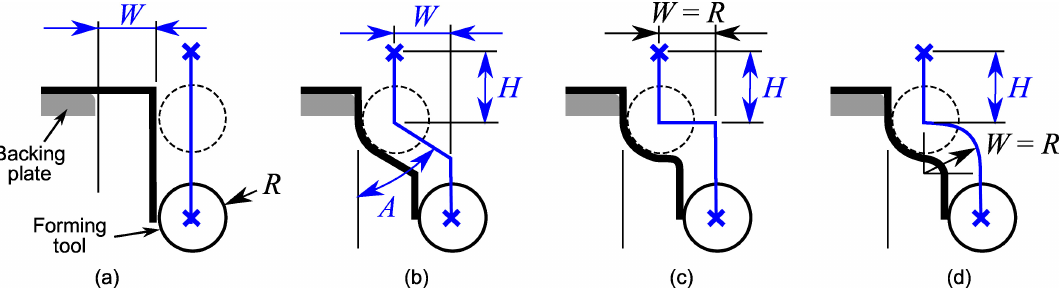
Figure 5. Schema of the first stage in hole-flanging by two-stage SPIF: ( a ) straight section due to Cui and Gao [9]; ( b ) 3-parameter section analysed in [12]; ( c ) prototype based on the three-parameter section; and ( d ) proposed